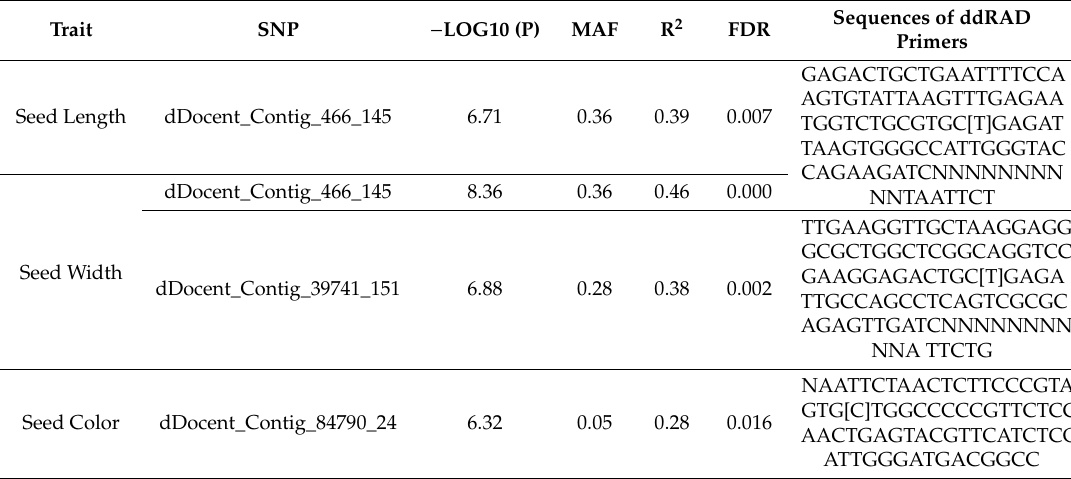
Table 1. Significant SNPs associated with seed length, width, and color of 112 fenugreek genotypes detected using mixed linear model. MAF = minor allele frequency, R 2 = explained phenotypic variance, FDR = false discovery